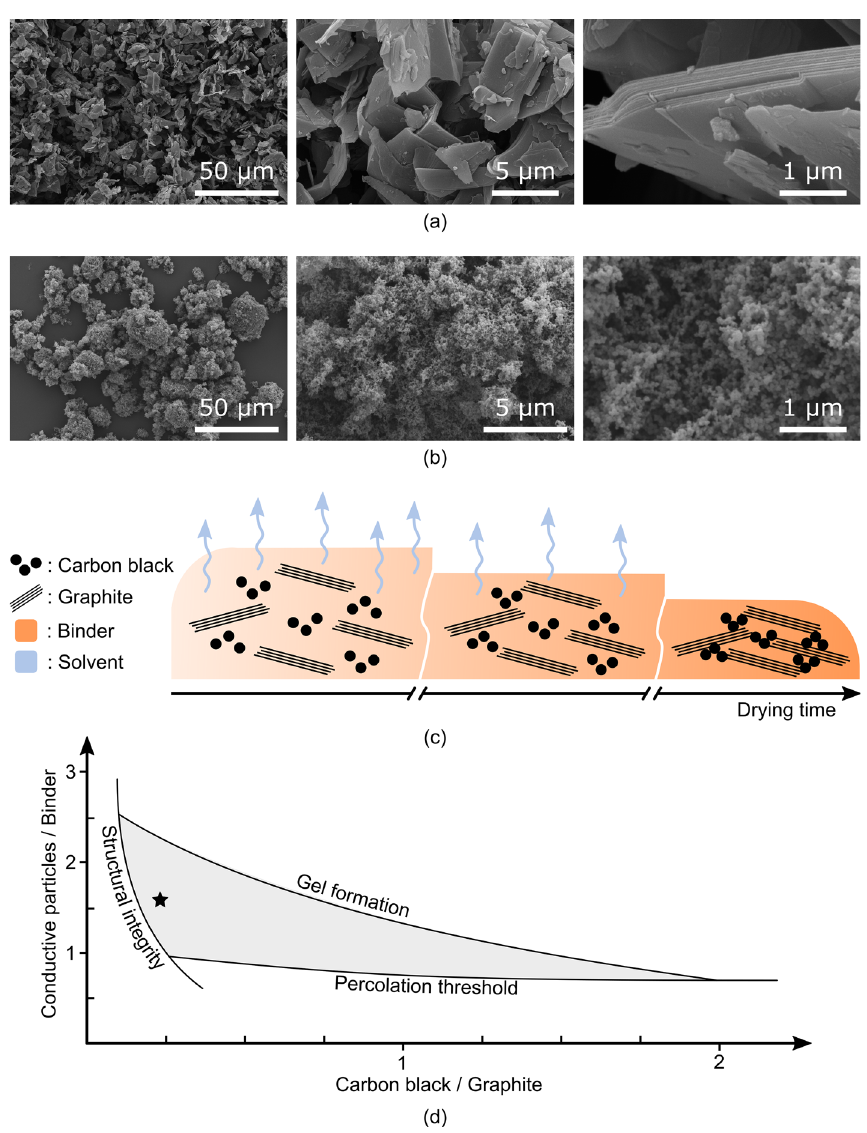
Figure 1. (a) SEM micrographs of the graphite flakes that confer electrical conductivity to the composite ink. (b) SEM micrographs of the carbon black particles that ensure good electrical contact between the graphite flakes, as well as provide shear thinning gel properties to the ink. It can be seen from the higher magnification micrographs that large particles visible at lower magnification are in fact aggregates of nanosized carbon particles. (c) Illustration showing the different ink constituents, their distribution, and the creation of an electrical percolation network as solvent evaporates. (d) Chart presenting the range of working ink formulation as a function of the conductive particles/binder and graphite/carbon black ratios. The star identifies our optimal formulation. The need for structural integrity (i.e. no cracks formation during drying stage), shear thinning gel rheology, and electrical percolation network are the main limiting